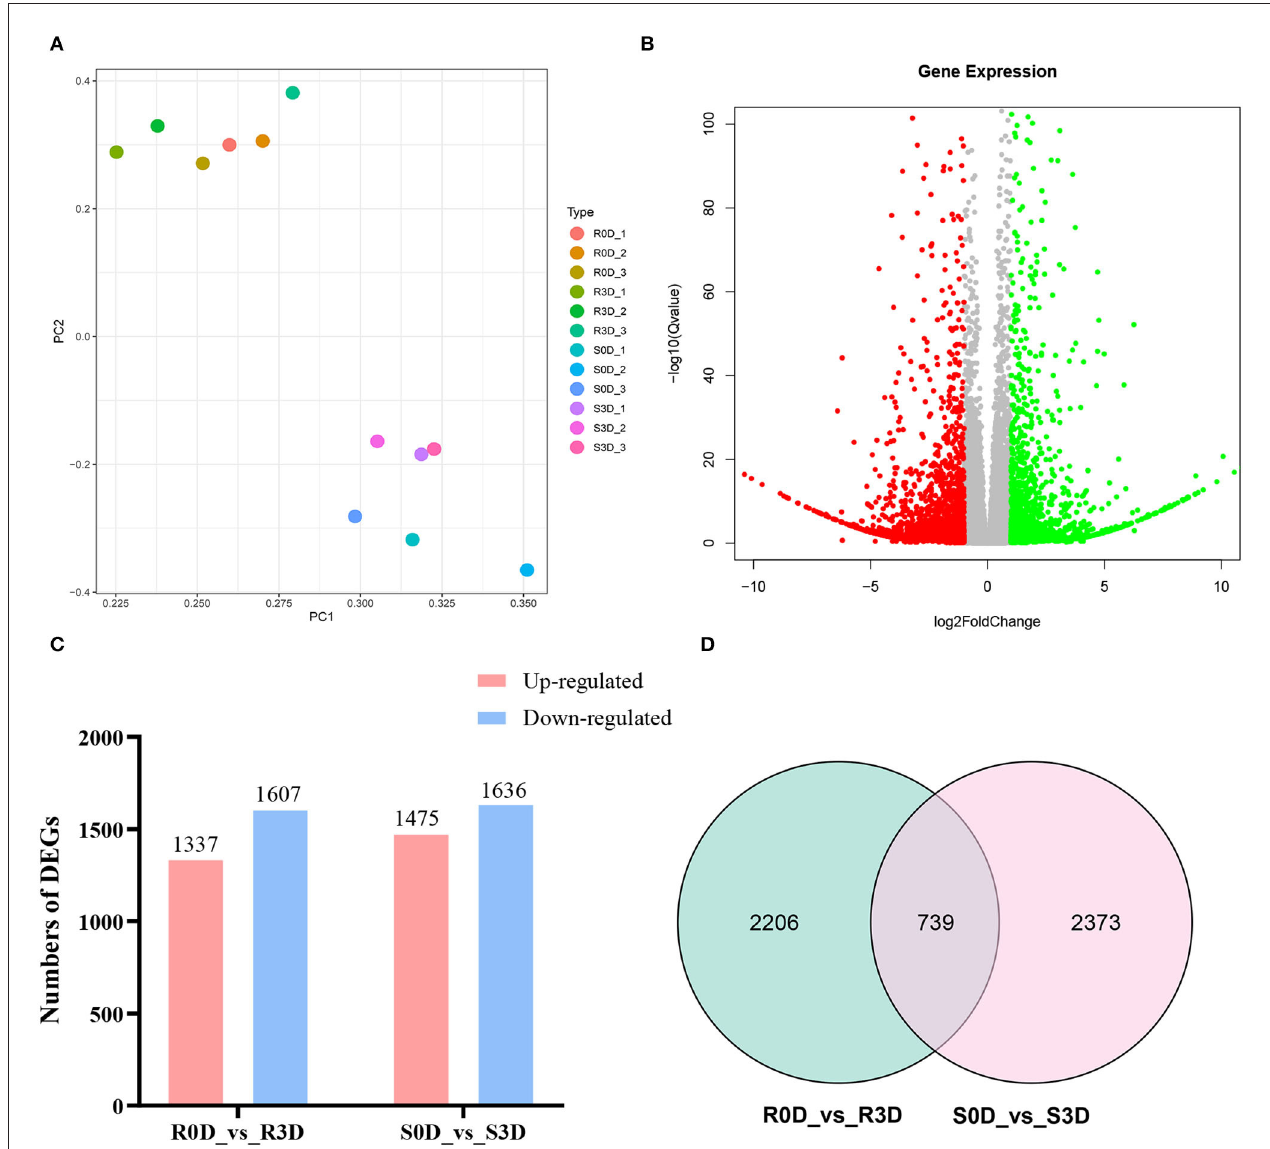
FIGURE 4 | Comparative transcriptome analyses for differentially expressed genes (DEGs) in the two parent lines after inoculation with Pb10. (A) Principal component analysis (PCA) of 12 samples. (B) Volcano plot of DEGs in resistant parent group of R0D vs. R3D. (C) Numbers of DEGs in the two groups of R0D vs. R3D and S0D vs. S3D. (D) The Venn diagram of DEGs in the two groups of R0D vs. R3D and S0D vs. S3D. “R” represents the resistant parent lines; “S” represents the susceptible parent lines; “0D” indicates the uninoculated samples; and “3D” indicates that the samples have been collected at 3 days after inoculation with the Pb10